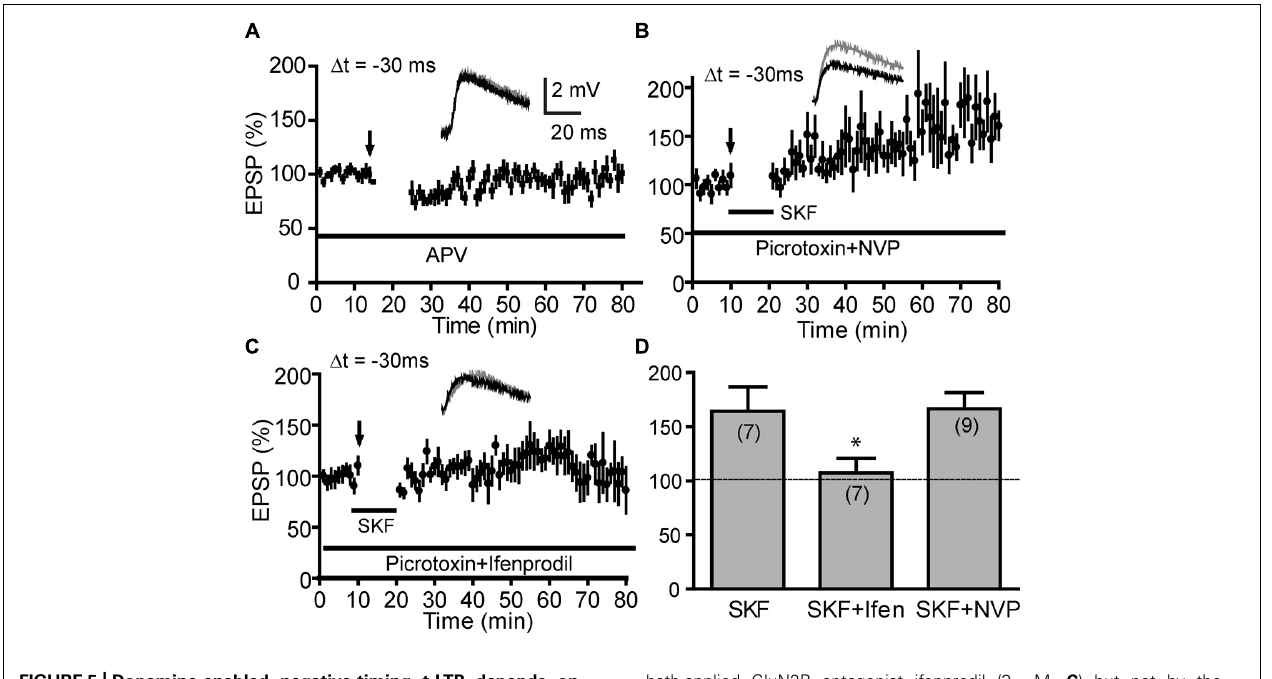
FIGURE 5 | Dopamine-enabled negative-timing t-LTP depends on GluN2B-NMDARs. (A) DA-enabled t-LTP at Δ t = − 30 ms under intact GABAergic condition was blocked by bath-applied NMDAR antagonist APV (50 μ M). (B,C) Effects of GluN2 subunit antagonists on SKF81297 (2 μ M)-enabled t-LTP at − 30 ms in the presence of picrotoxin (50 μ M). The negative-timing t-LTP was blocked by